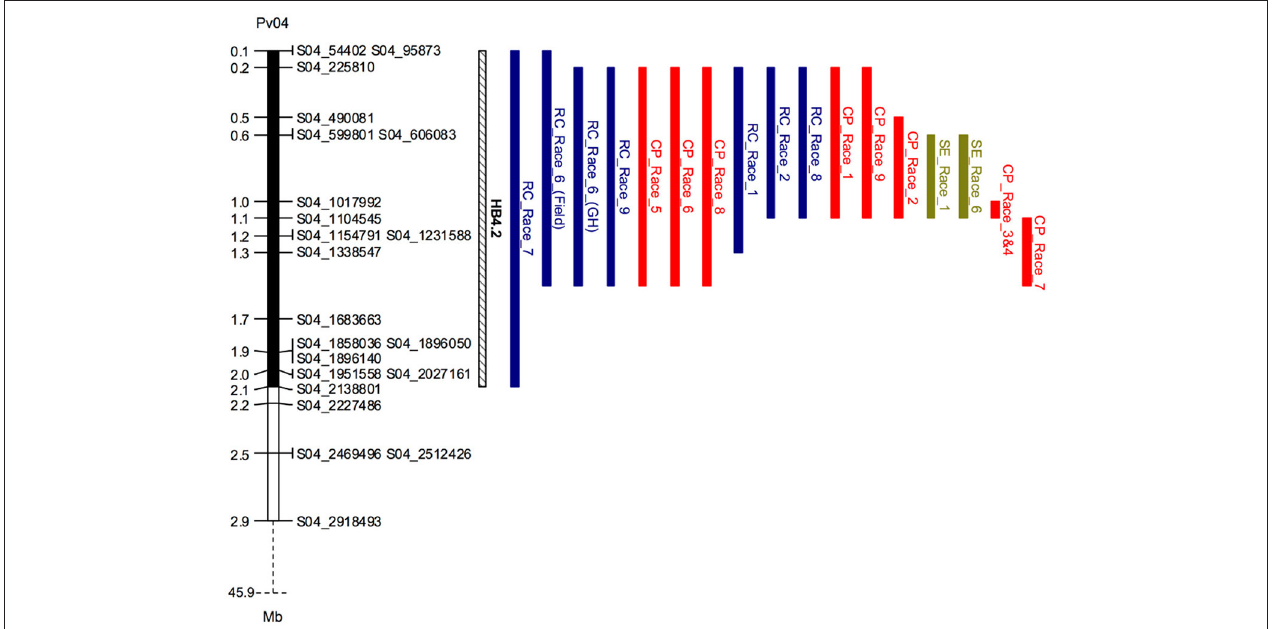
FIGURE 3 | Co-localizing major-effect QTL (HB4.2) on Pv04 conferring resistance to multiple races of Pseudomonas syringae pv. phaseolicola ( Psph ) in SOA-BN × Edmund (SE; green), Canadian Wonder × PI 150414 (CP; red) and Rojo × CAL 143 (RC; blue) recombinant inbred populations. The physical boundaries of QTL 1.8-LOD support intervals are depicted as vertical bars, with population and Psph race indicated to the right of each interval. The locations of the closest SNP markers delimiting QTL intervals in the P. vulgaris v1.0 reference genome (Schmutz et al., 2014) are provided in megabase pairs (Mb). For clarity, the image depicts a magnified view of the top of